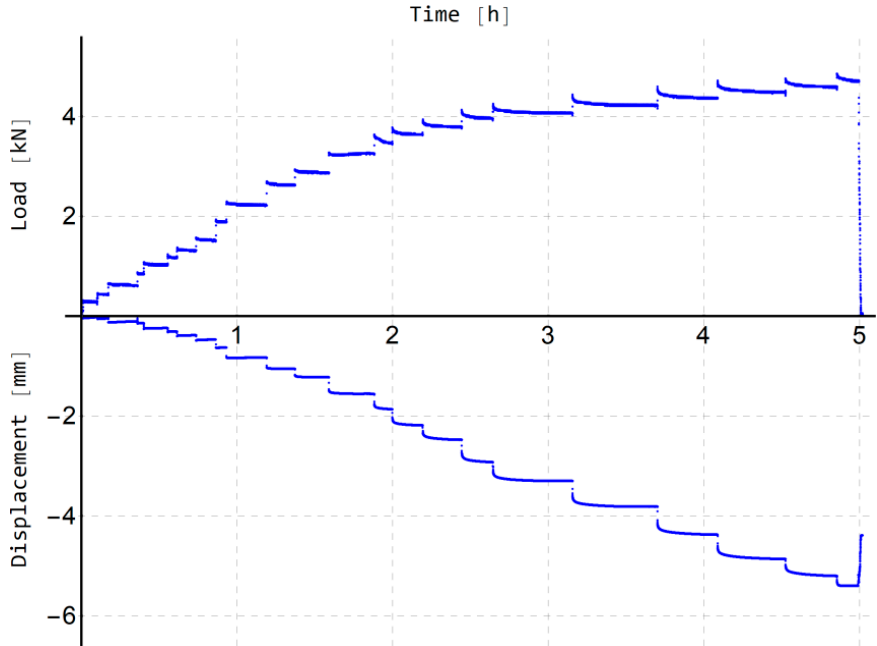
( b ) Figure 7. Concept of traditional static load tests ( a ) and scheme of bi-directional tests ( b ), 1: uplifted steel pipe, 2: compressed pole of dynamic probe, 3: frame composed by the two flat plates and four threaded bars, 4: steel collar attached to the pile head with three horizontal set bolts 5: load cell, 6: manual jack. ( a ) ( b ) Figure 8. Stands for traditional static load tests ( a ) and bi-directional tests ( b ). Successive loads were applied step by step (by 0.2–0.3 kN increments) after the settlement of the